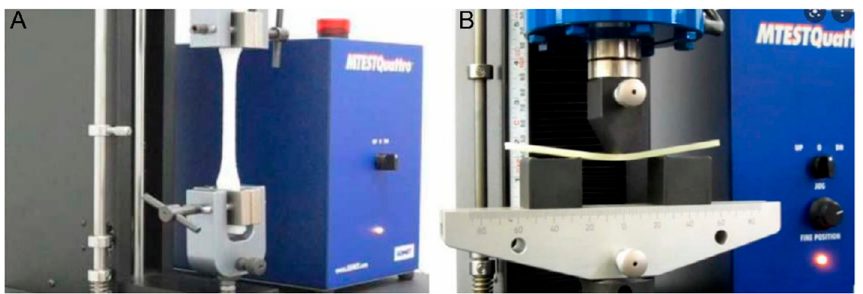
Figure 10. Comparison of the tensile strength ( A ) and flexural strength ( B ) measurement methods using a UTM.